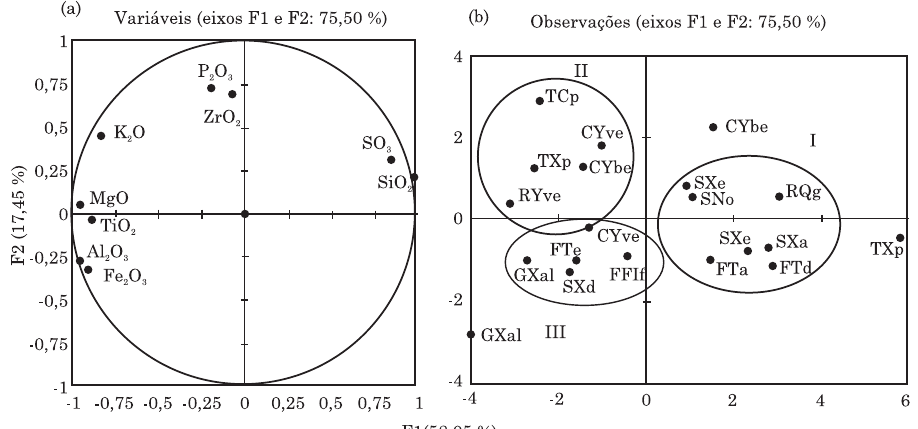
Figura 3. Análise de Componentes Principais (ACP) dos teores médios de elementos (óxidos) dos solos da RPPN SESC Pantanal, por perfil (n = 20). (a) variáveis componentes; e (b) grupos de